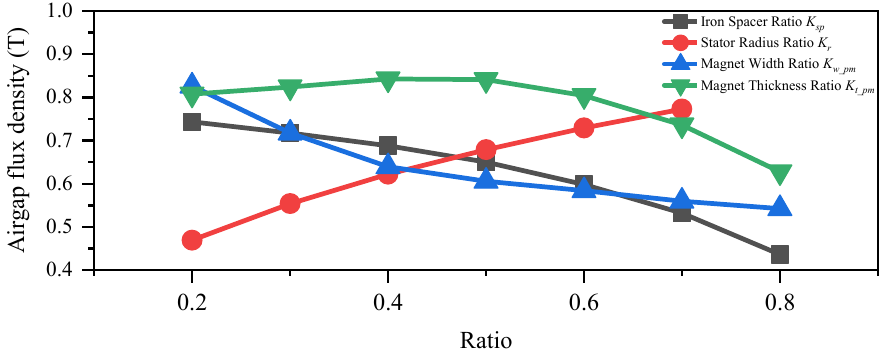
Figure 5. Variation of flux density in the air-gap B r design